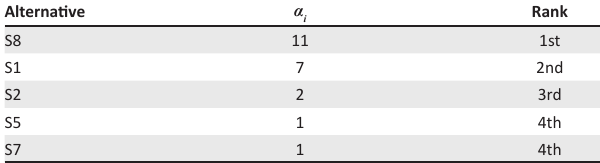
TABLE 14: Choice stage for the remaining alternatives. TABLE 10: Filtering step for upper quartile.